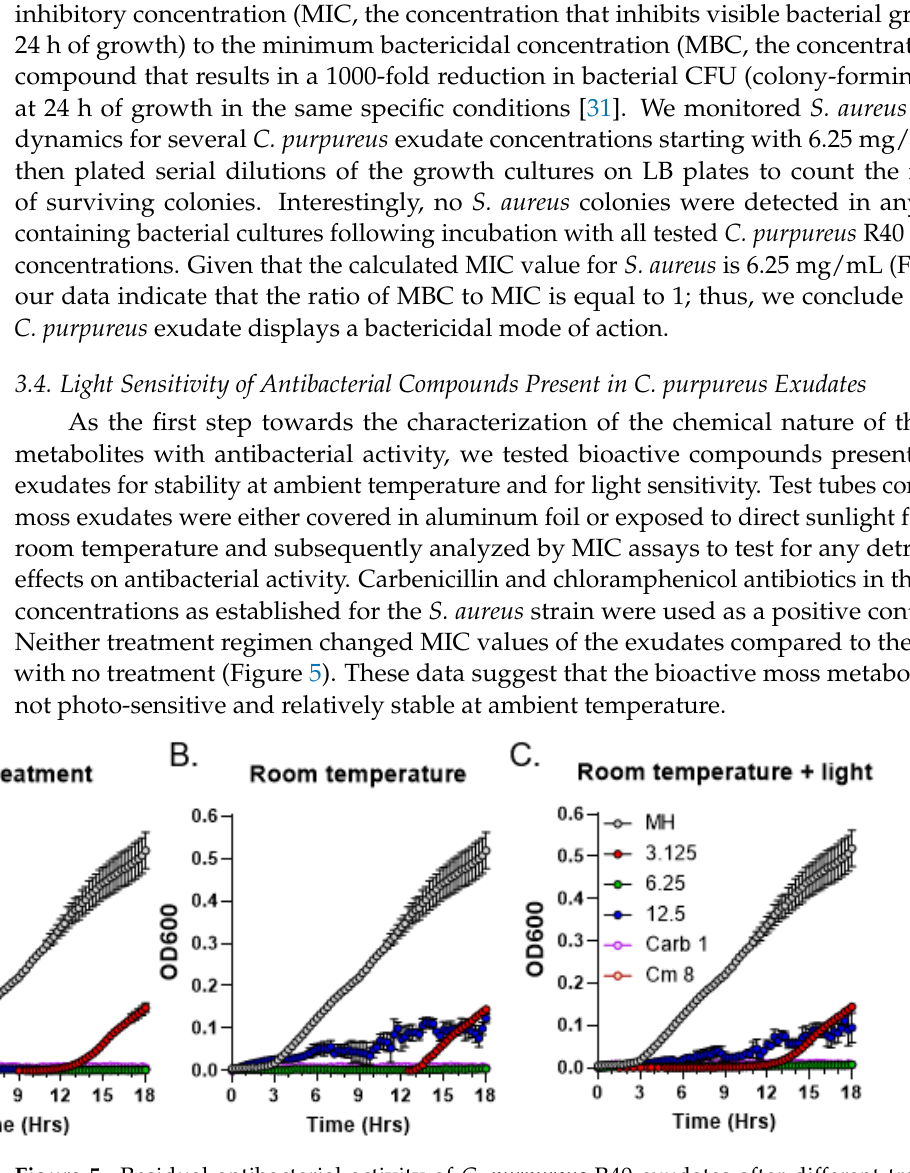
Figure 5. Residual antibacterial activity of C. purpureus R40 exudates after different treatments. Residual activity of exudate from four-week-old C. purpureus R40 culture was tested after treatments by MIC assays against S. aureus. ( A ) Samples were used in the assay immediately, without keeping them for 3 h at room temperature (untreated control). Samples were also kept at room temperature and either protected from light ( B ) or exposed to direct sunlight ( C ). Experiments were performed using 3.125, 6.25, and 12.5 mg/mL exudate concentrations. Carbenicillin (Carb, 1 µg/mL) and chloramphenicol (Cm, 8 µg/mL) were used as positive controls. MH, S. aureus growth in liquid MH medium without exudate addition.